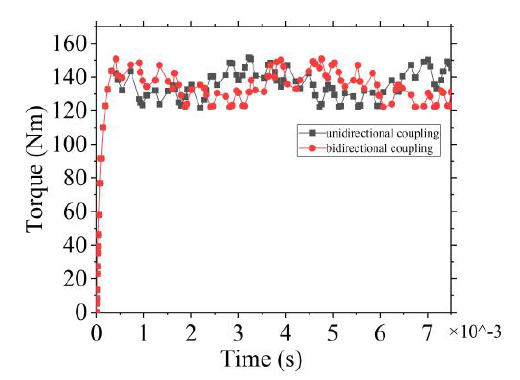
Figure 9. Unidirectional coupling and bidirectional coupling simulation results.